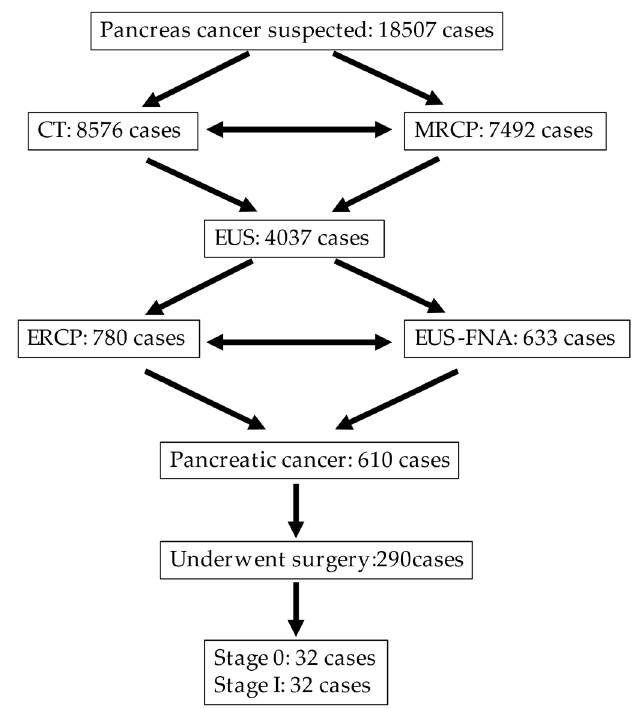
The flow of patient information. The results of the Onomichi Project for the diagnosis of pancreatic cancer. ENPD: endoscopic nasopancreatic drainage, ERCP: endoscopic retrograde cholangiopancreatography, EUS: endoscopic ultrasonography, FNA: fine-needle aspiration, MRCP: magnetic resonance cholangiopancreatography.